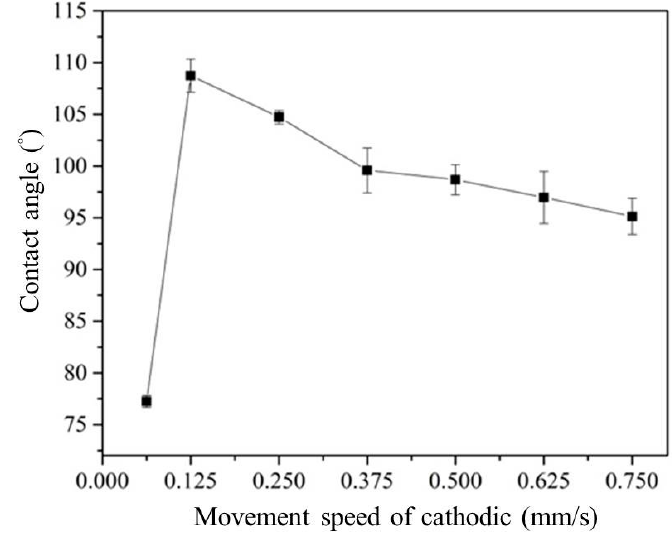
Figure 10. Contact angle mean and standard deviation values for different cathodic specimen speeds when the electrode distance of 20 mm and the applied voltage of 220 V are fixed.